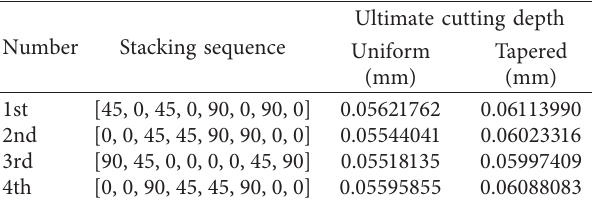
Table 4: Comparison of the ultimate cutting depth of different stacking sequences.